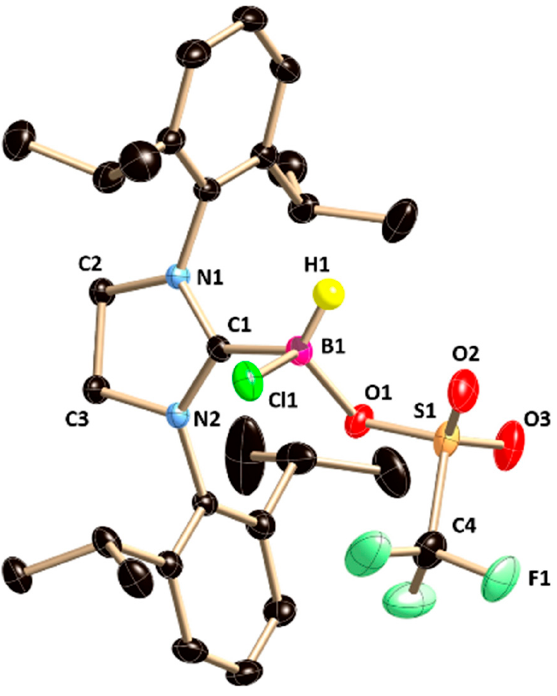
Figure 4. The molecular structure of 4 . Hydrogen atom expect H1 in 4 are omitted for clarity. Selected bond lengths [Å] or angles [deg]: N1–C1 1.316(4), N2–C1 1.337(4), C2–N1 1.471(4), C3–N2